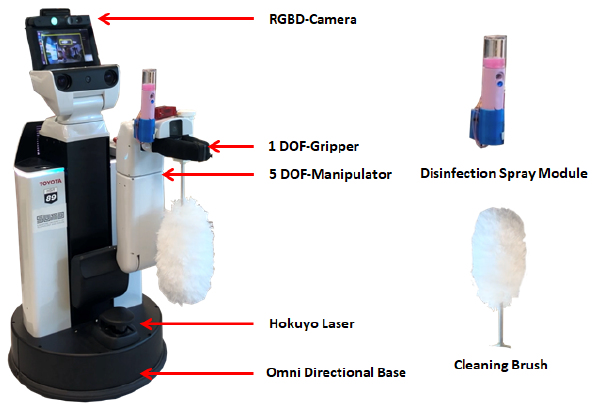
Figure 1. HSR platform with cleaning module.